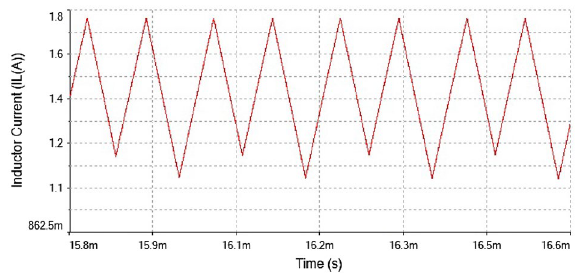
Figure 23. Inductor current waveform for forward converter at R L = 7.5 (cid:31) .